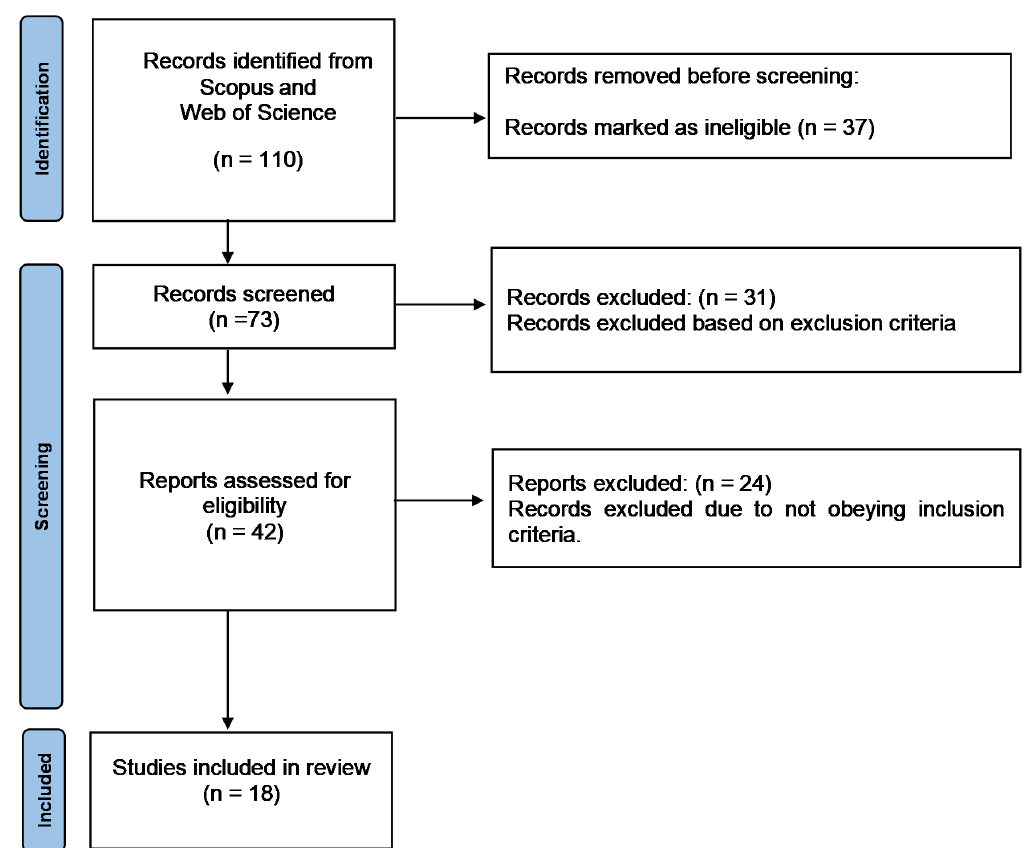
Figure 2. PRISMA results for current paper, format (adapted from Moher et al. [23]).